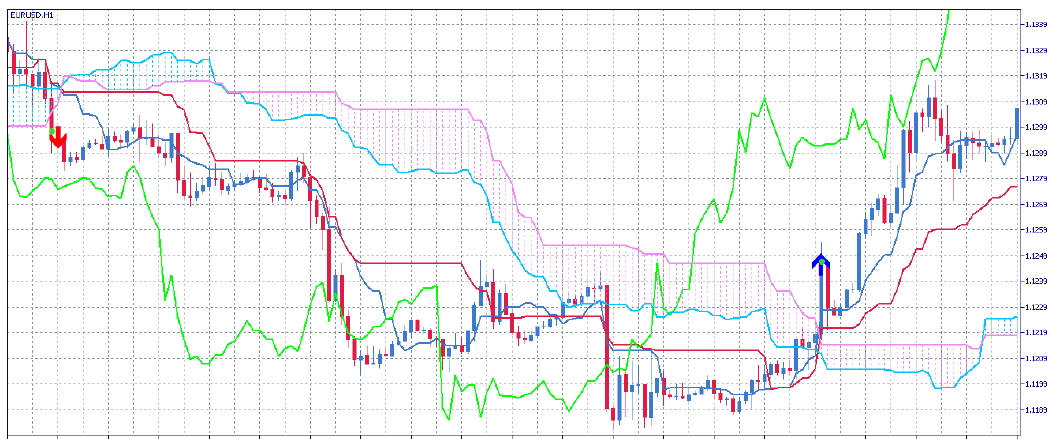
Figure A5. EUR/USD chart with signals from the AdIchimoku strategy